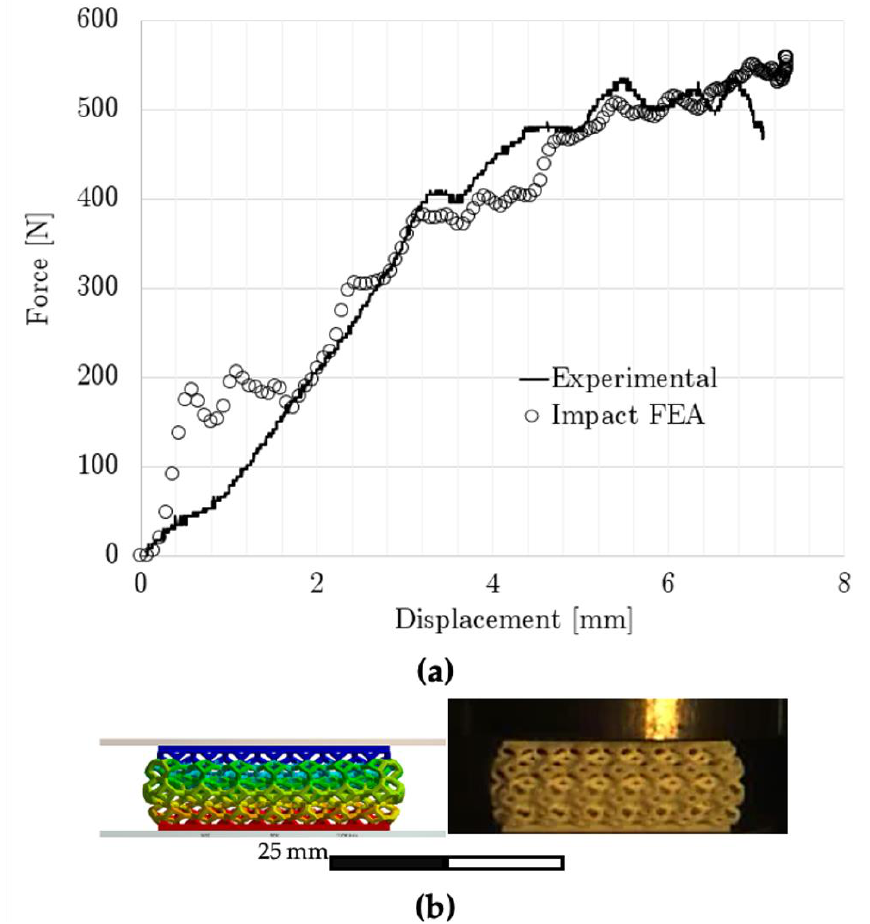
Figure 13. Non-graded lattice numerical results: ( a ) impact force–displacement curve comparison and ( b ) maximum compression under simple impact.